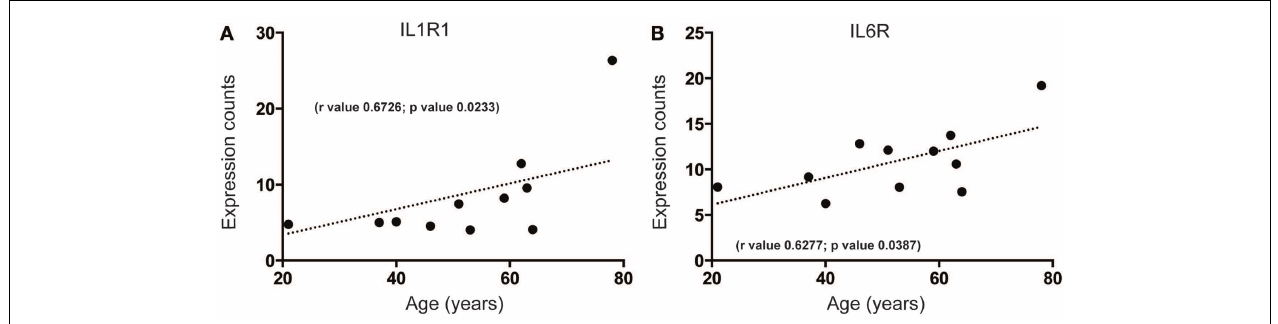
FIGURE 3 | Inflammatory receptor mRNAs related to senescence increase in the human SEZ with age . Significant increases during aging are observed in the expression levels of (A) interleukin-1 receptor 1 (IL1R1) and (B) interleukin-6 receptor (IL6R). (Significance is defined as p value < 0.05).